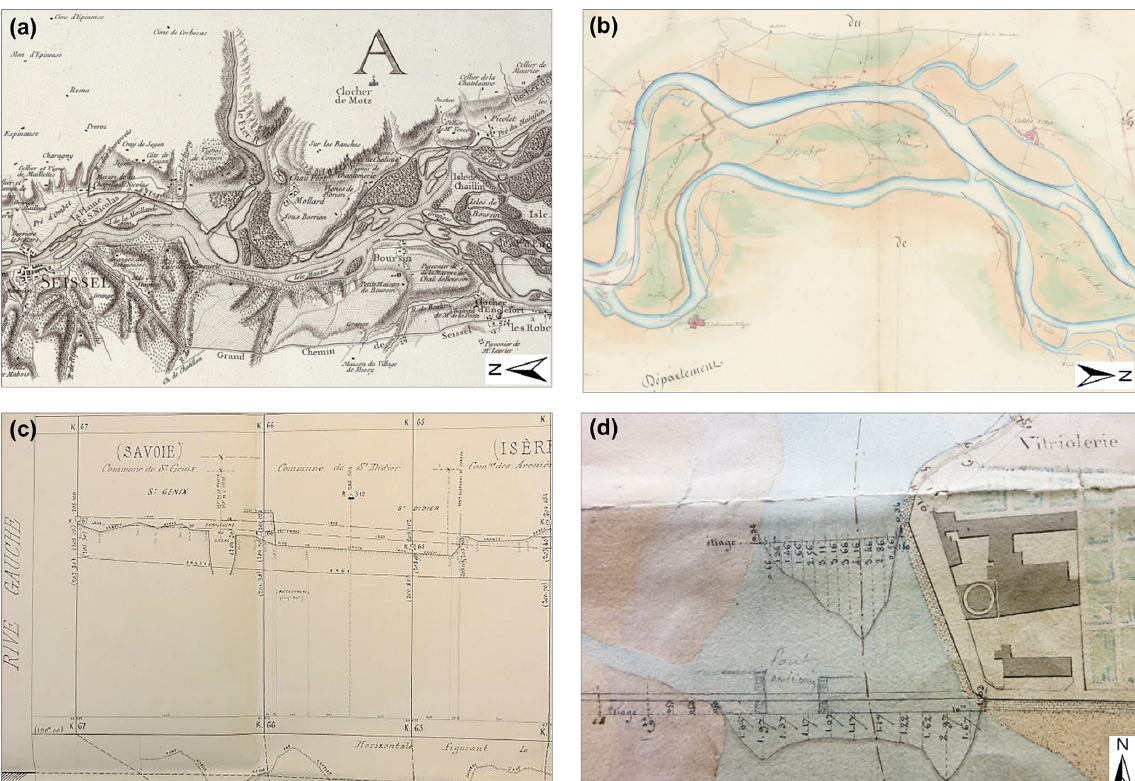
Figure 3. Examples of the archive resources collected in this study. (a) Map series at 1:28246 between Geneva and the Guiers confluence, 1760. Extract of sheet no. 3/7 (source: De Bourcet, AD Savoie, 1Fi S52–53). (b) Map series at 1:10000 from Geneva to the Mediterranean Sea, 1842. Extract of sheet no. 20/25 (source: Arnaud, National Archives, CP/F/14/10074/2/Piece 8). (c) Long profile of the left bank and the thalweg of the upper Rhône, 1869. Extract of sheet no. 6/6 (source: Ponts et Chaussées , AD Rhône, S 1356). (d) Bathymetric information on a map at 1:2000 in Lyon, 1833 (source: Garella, AD Rhône, S